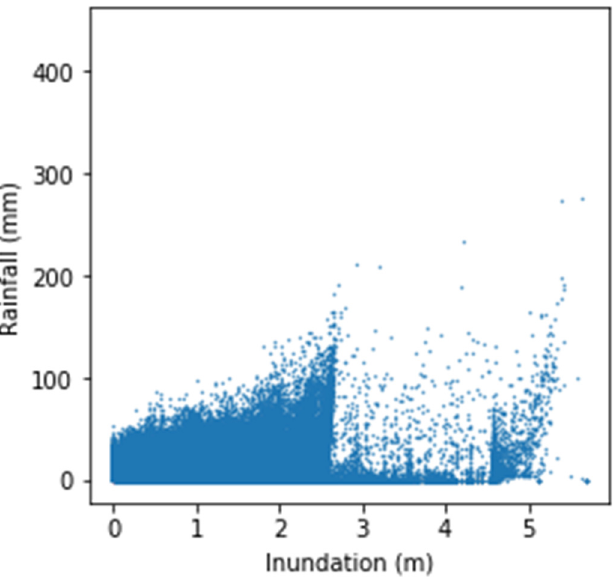
Figure 2. Relationship between maximum 1-h rainfall and maximum flooding depth.